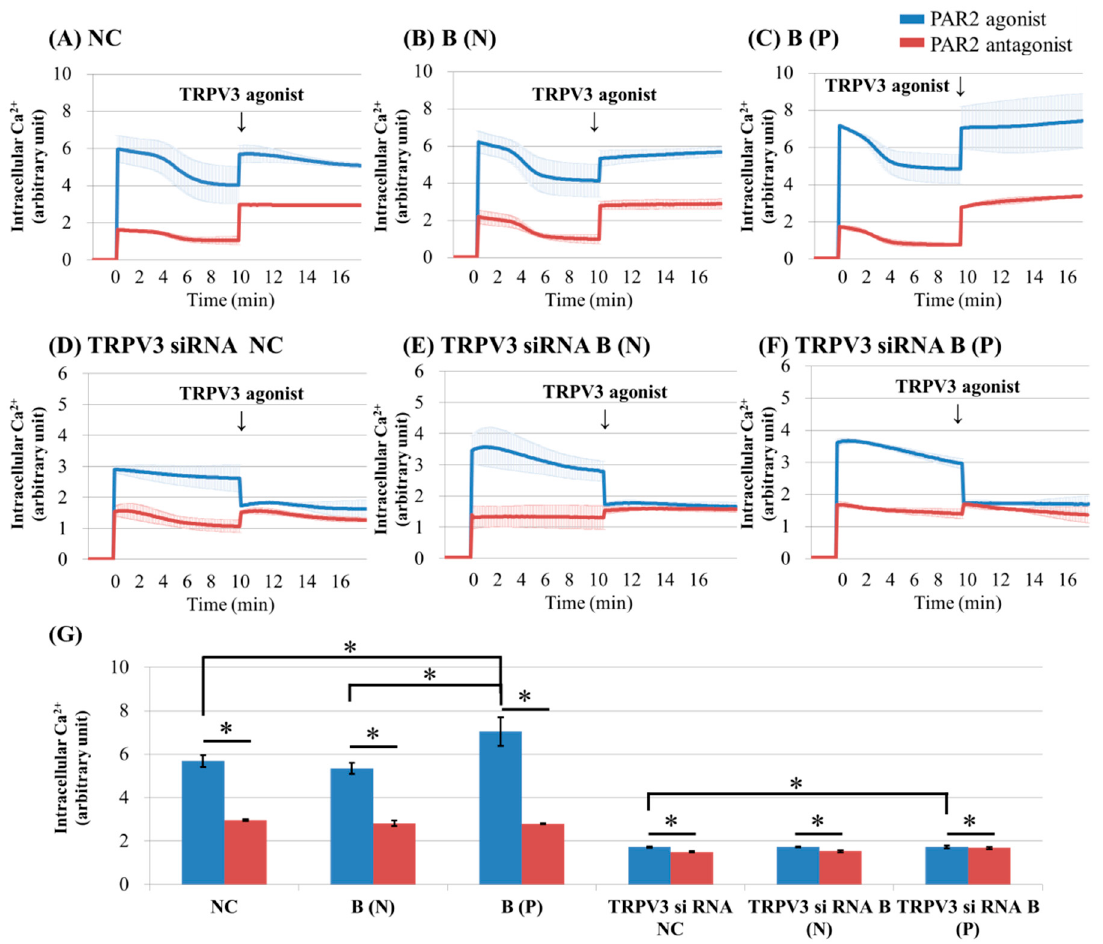
Figure 2. Ca 2+ influx in cultured keratinocytes of: ( A ) Normal control; ( B ) nonpruritic burn scar; ( C ) pruritic burn scar; ( D ) TRPV3 siRNA transfected normal control; ( E ) TRPV3 siRNA transfected nonpruritic burn scar and ( F ) TRPV3 siRNA transfected pruritic burn scar; ( G ) Intracellular Ca 2+ levels at the time of TRPV3 agonist treatment. Each group was pretreated with protease-activated receptor 2 (PAR2) agonist (100 μ M SLIGRL-NH2) or PAR2 antagonist (100 uM LRGILS-NH2); then TRPV3 agonist (500 μ M Carvacrol and 200 μ M 2-APB mixture) was added. PAR2 agonist induced intracellular Ca 2+ influx in cultured human keratinocytes of normal (unscarred), and in nonpruritic and pruritic burn-scar tissues. The pruritic burn scars showed the highest level of intracellular Ca 2+ influx. Unlike normal tissue, keratinocytes from scar tissue showed a pattern of increasing intracellular Ca 2+ . In keratinocytes transfected with TRPV3 siRNA, PAR2 agonist increased the level of intracellular Ca 2+ , but TRPV3 agonist decreased it. NC: keratinocytes from normal control; B (N): keratinocytes from a nonpruritic burn scar; B (P): keratinocytes from a pruritic burn scar; Error bars in ( A – F ): standard deviation of the mean value obtained from three experiments; Error bars in ( G ): standard error, each performed in triplicate.* p < 0.001.